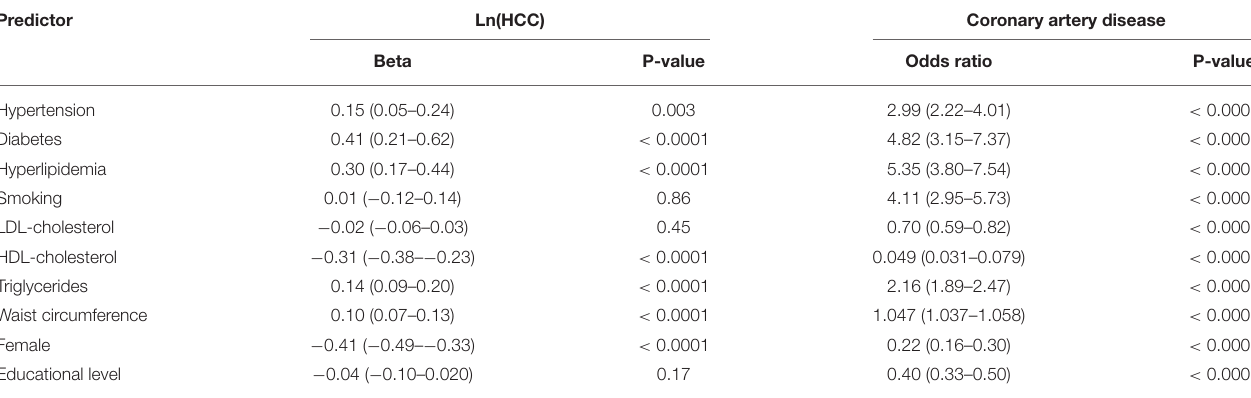
TABLE 2 | Screening of potential mediators to be included in the path analysis.